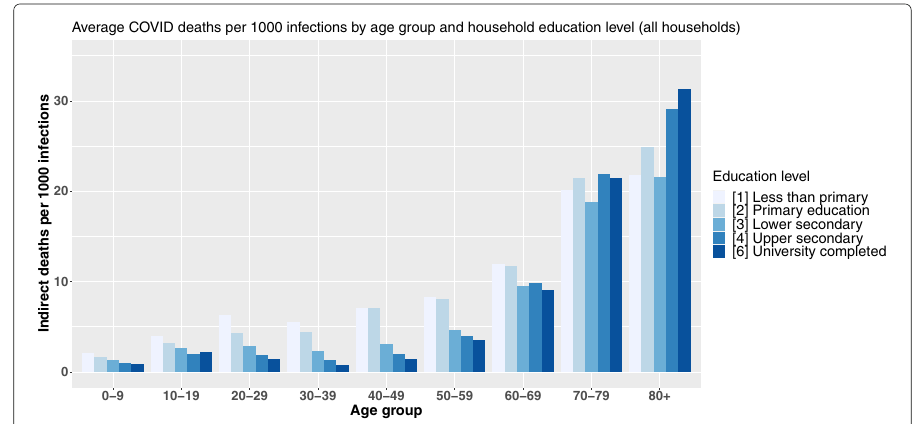
Fig. 3 Average COVID-19 indirect deaths per 1000 infections by age group and head-of-household education level